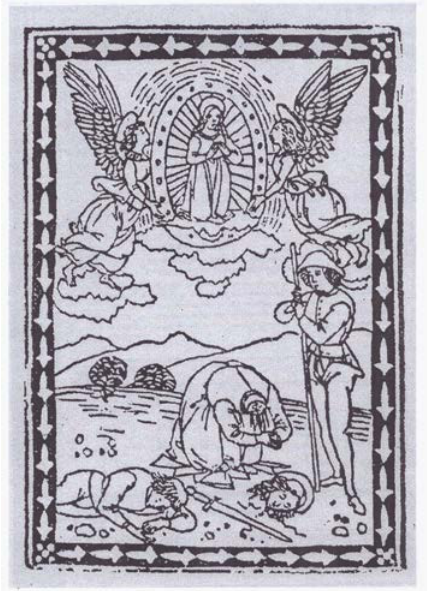
Figure 25 – La Rapresentatione di Sancta Agata Vergine & Martyre , ad instantia di ser Piero Pacini da Pescia, s.l.a. [but Firenze, Bartolomeo de’ Libri, around 1496?], f. b4r (BNCF, Banco Rari 179.8). By permission of Ministero per i beni e le attività culturali / Biblioteca Nazionale Centrale.